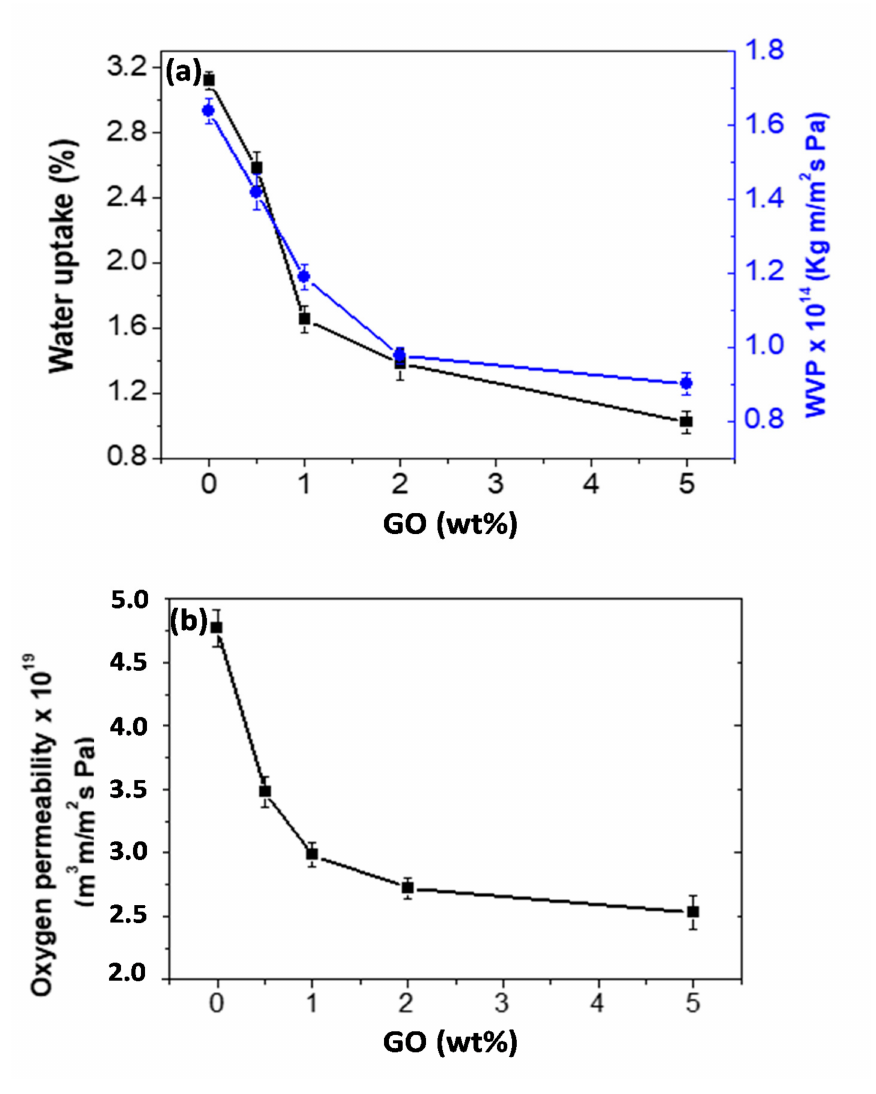
Figure 6. ( a ) Water uptake and water vapour permeability (WVP) and the ( b ) oxygen permeability of PHBHHx nanocomposites as a function of GO